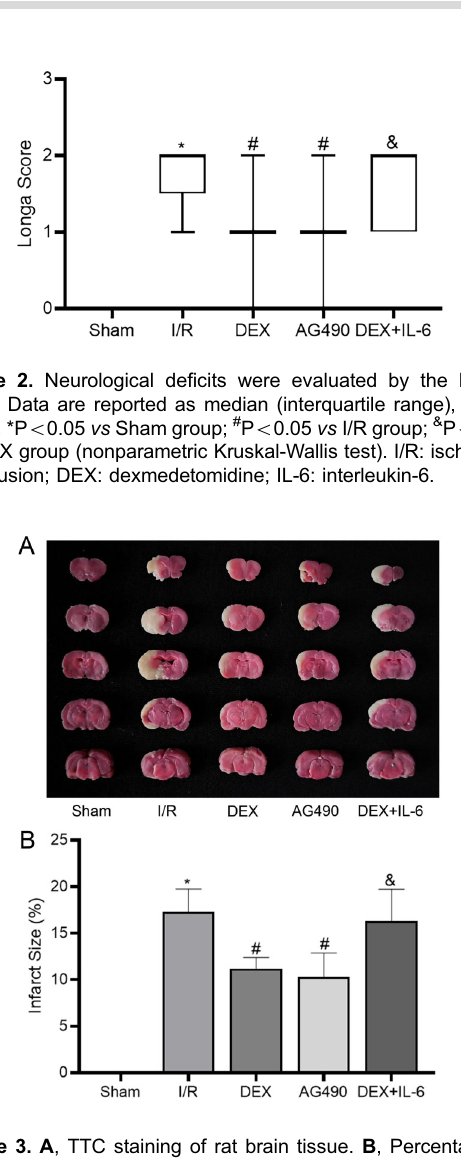
Figure 3. A , TTC staining of rat brain tissue. B , Percentage of cerebral infarction area. Data are reported as means ± SD, n=5. *P o 0.05 vs Sham group; # P o 0.05 vs I/R group; & P o 0.05 vs DEX group (one-way ANOVA). I/R: ischemia/reperfusion; DEX: dexmedetomidine; IL-6: